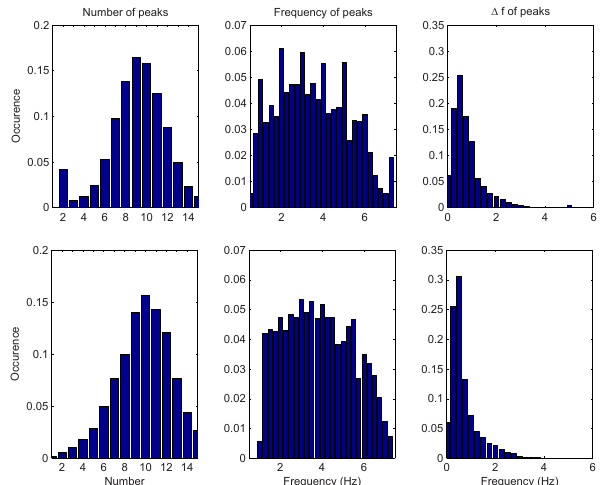
Figure 3. Image processing protocol for identifying continuous SRS features for 14–15 February 2014. See text for details. (a) Im- age of peak “spots” identified in the smoothed FFT data; (b) di- lation, erosion and bridging of “spots” image; (c) computation of weighted mean position of SRSs; (d) superposition of SRS peak locations with spectrogram. Features outside 18:00 and 06:00 are ignored in (b) , (c) , and (d) .